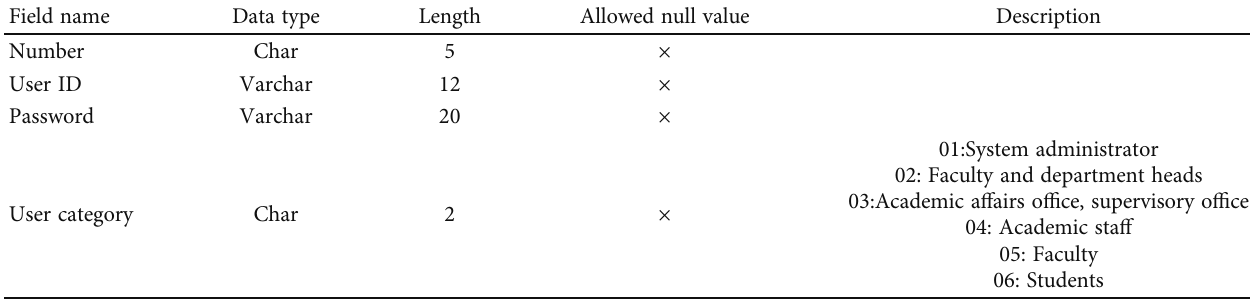
Table 4: Username summary.